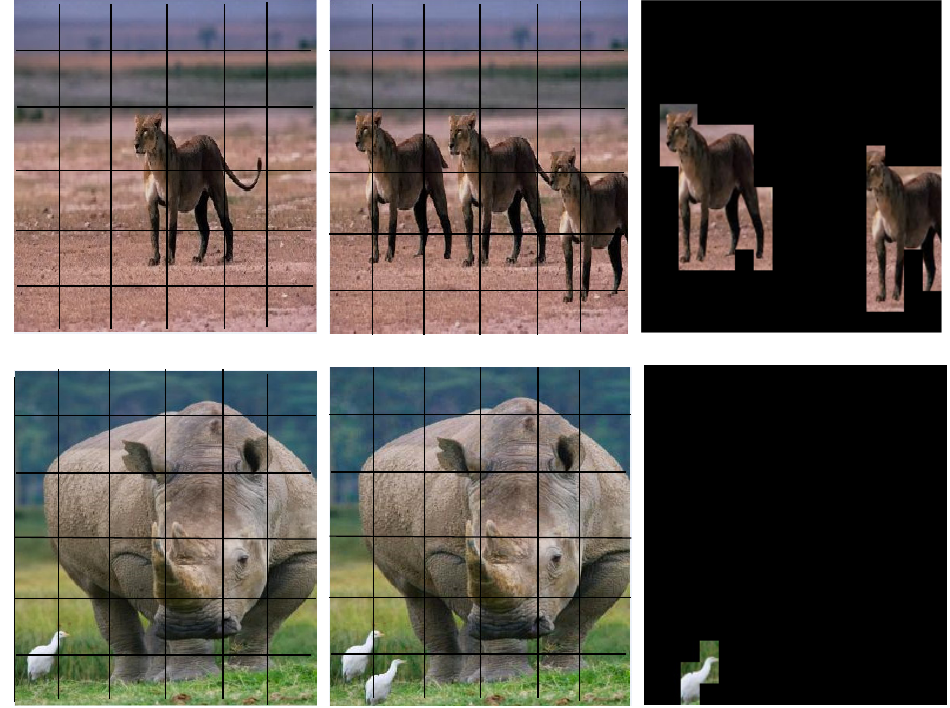
Figure 6. Examples of forgery detection results from the CASIA V 1.0 dataset: the original image, the forged image and the forgery detection result.